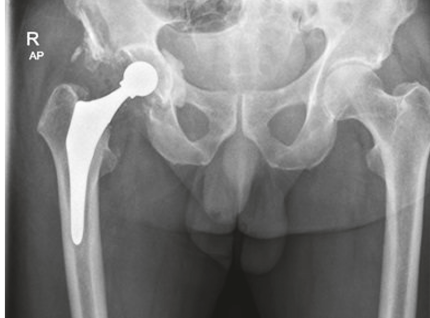
Figure 2: AP radiograph, 6 weeks following revision arthroplasty, demonstrating a polyethylene cup combined with a cobalt-chro- mium (CoCr) femoral head.